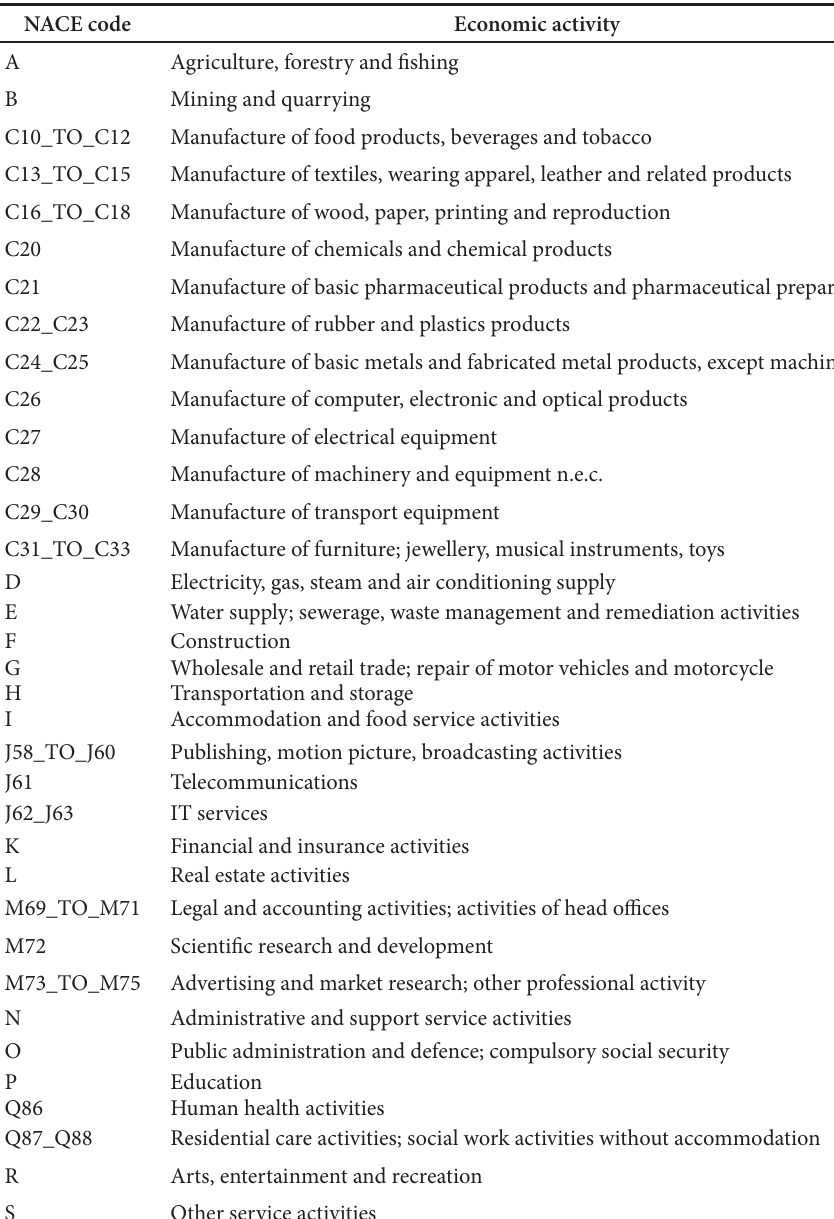
Table A1. Aggregates of statistical classification of economic activities (NACE Rev. 2) used in the research NACE